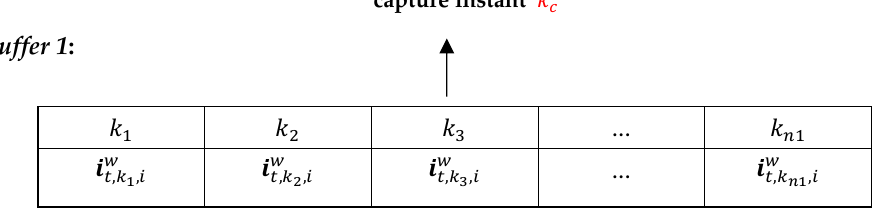
Figure 8. Information vector storage buffer i w of the t -th target in the i -th camera, k = k 1 , . . . , k n 1 . t , k , i Information vectors are sent and received by the i -th camera within the time window (cid:16) (cid:17) = [ k − α + α ] , α 1 > 0 and α 2 > τ i about the capture instant k c , expressed as K i . c 2 1 , k c k k c The information vectors i w of the t -th target in the i -th camera ( Buffer 1 ) are aligned t , k , i according to their time stamps with respect to time stamps in the information vectors of various targets received from the j -th neighboring cameras ( Buffer 2 ). After the temporal alignment, C i will contain local information vectors ( Buffer 1 ) and received information vectors from the j -th neighboring cameras ( Buffer 2 ), as depicted in Figure